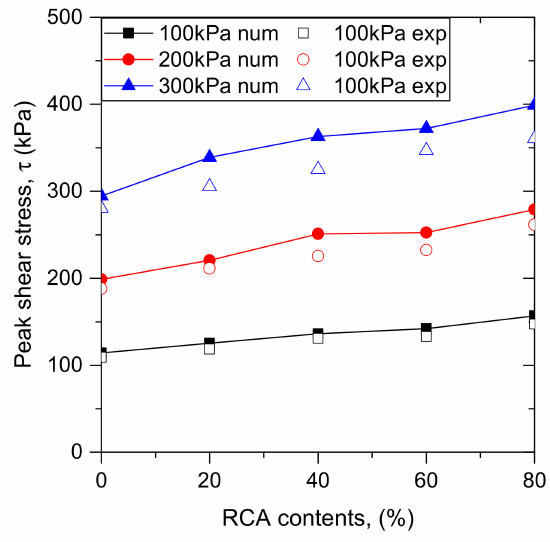
Figure 9. Relationship between peak shear stress and RCA